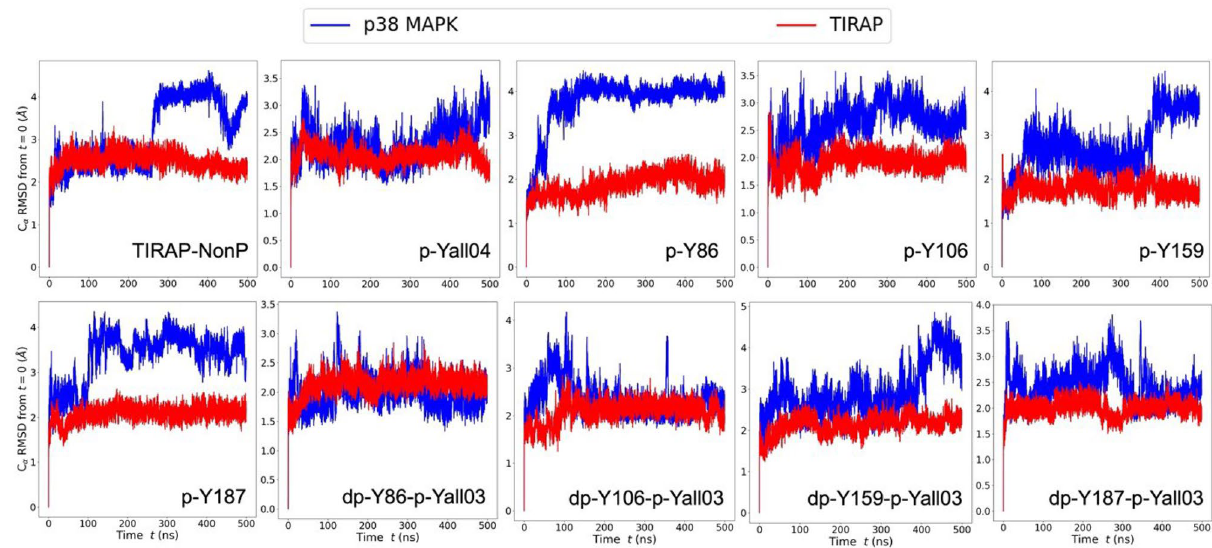
Figure 6. The root mean squared deviations (RMSD) of p38 MAPK and phosphorylated and non- phosphorylated TIRAP complexes. The RMSD plot of TIRAP (red) and p38 MAPK (blue) Cα atoms and their nine different molecular complexes for a total simulation time of 500 ns is shown.